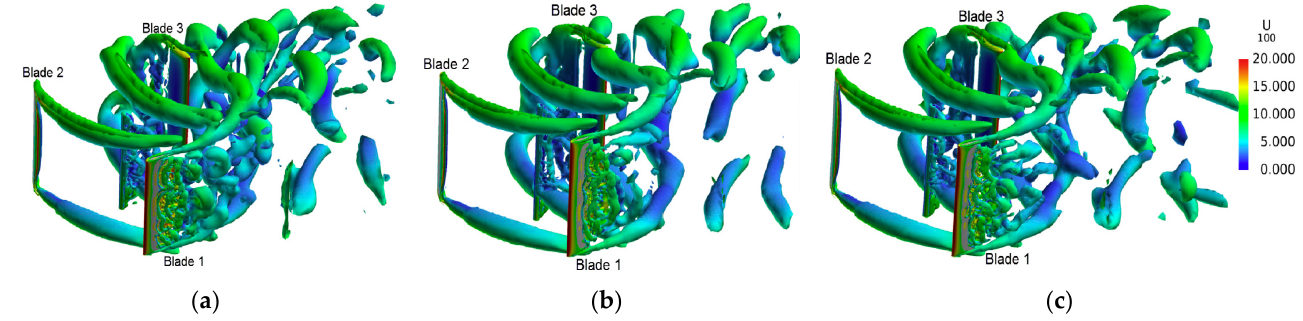
Figure 5. Coherent structures around an offshore vertical-axis wind turbine at ( a ) mean surge position, ( b ) maximum surge displacement and ( c ) no surge motion (Adapted with permission from ref. [16]. Copyright 2017 Energy).